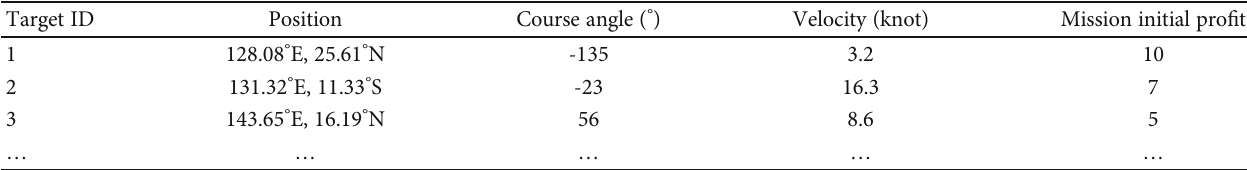
Table 1: Temperature and wildlife count in the three areas covered by the study.